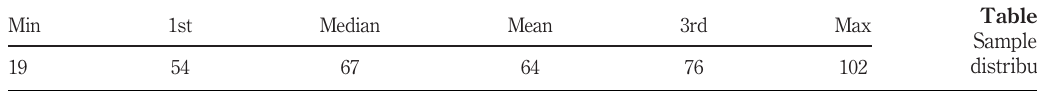
Figure 4. Sample sequence